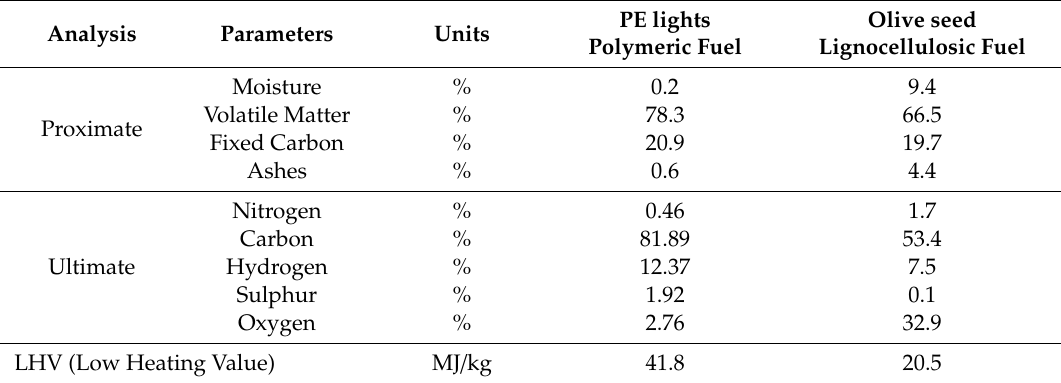
Table 8. Fuel analysis. (Source: self-made).